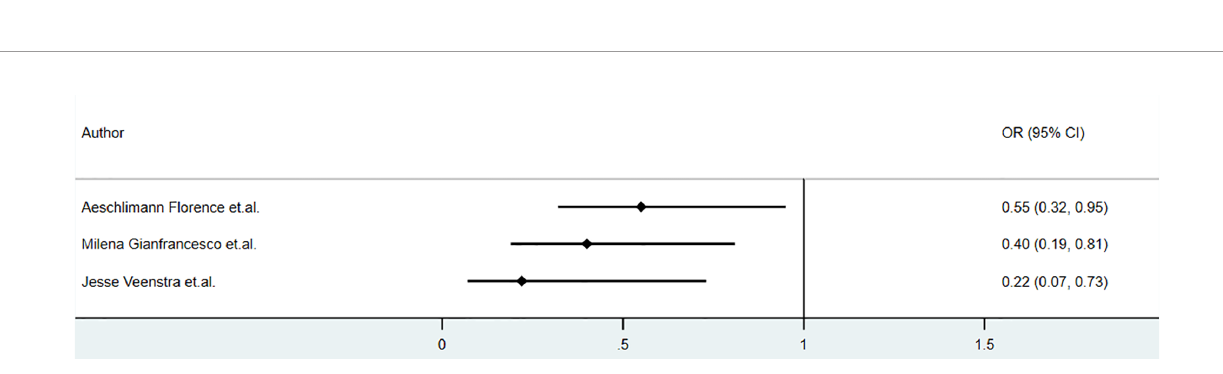
Figure 3 . A meta-analysis conducted by Anupam et al.